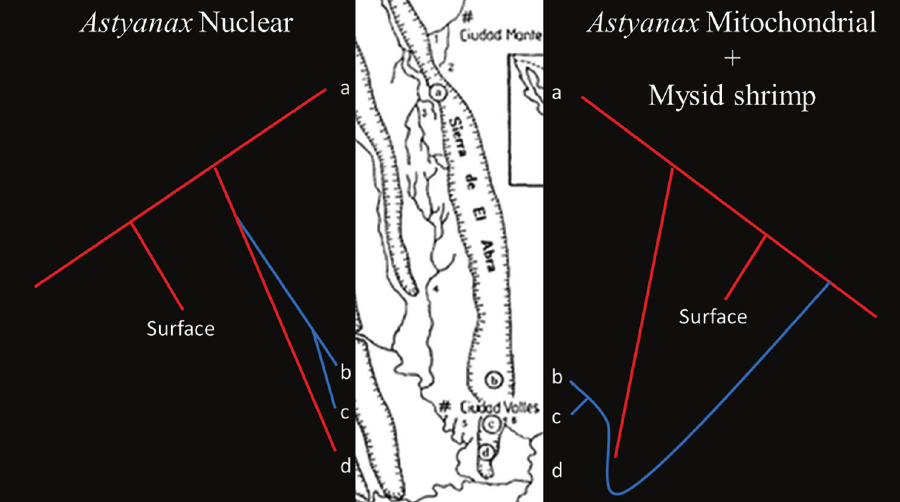
Figure 4. Pylogeographical convergence between mysid shrimps in the Sierra de El Abra and the mtDNA of Astyanax cavefish (right). Both aquatic species harbor the evolutionary signature of a phylogeographical discordance, where genetic markers of populations in central Sierra de El Abra are extremely distinct from the rest of the populations. Nuclear tree (left) based on the consensus of isoenzymes, RAPDs, microsatel- lite, and genomic sequences. a) Pachón as representative of northern populations. b-c) Sabinos and Tinaja as representative of central populations. d) Chica and Chiquitita as representative of southern